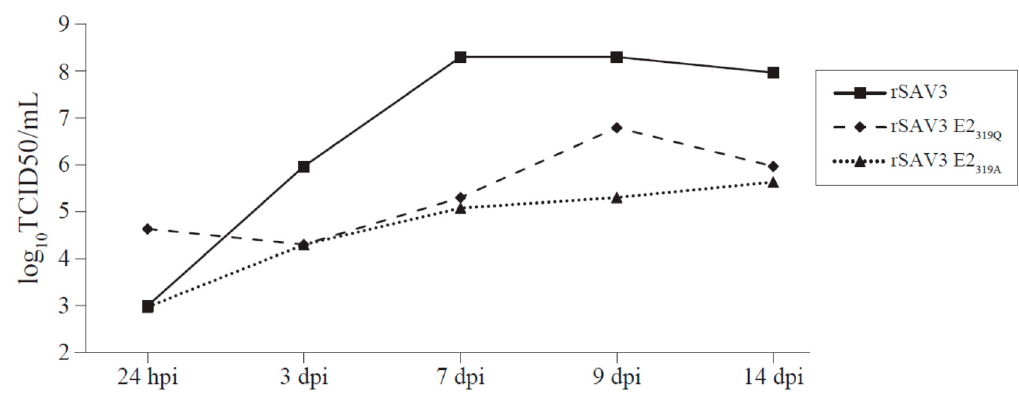
Figure 8. Tissue culture infective dose (TCID50 / mL) of rSAV3, rSAV3 E2 319Q and rSAV3 E2 319A mutants in media from the infected CHH cells.